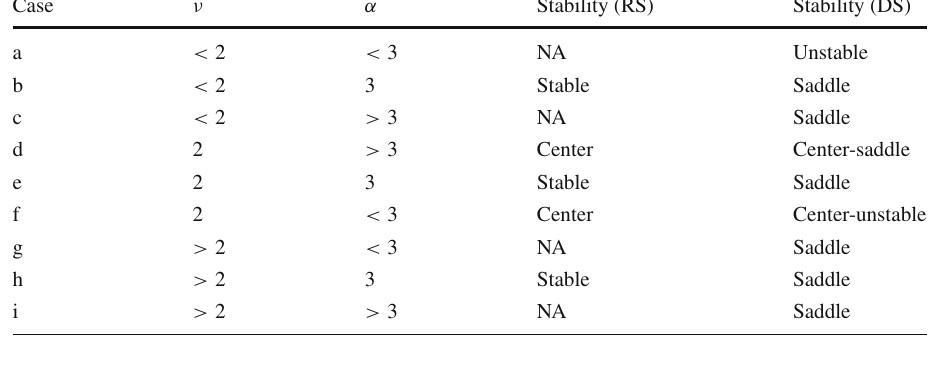
Table 11 C 5 (reduced